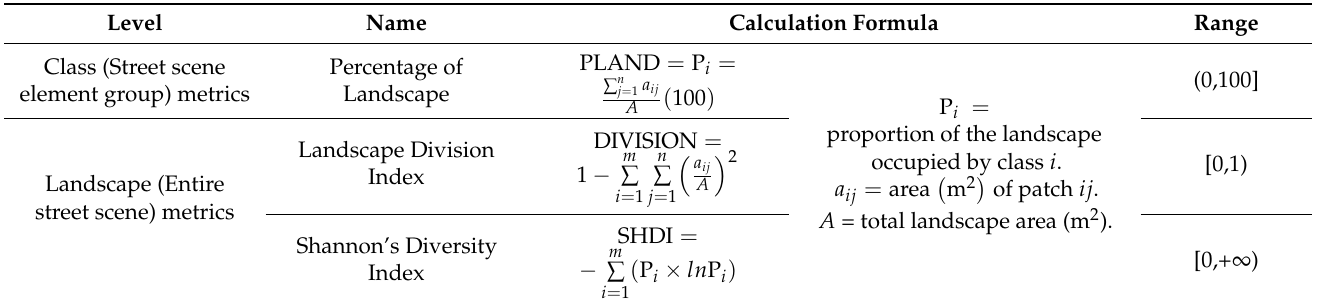
Table 1. Basic information of landscape pattern metrics in this study. Source: